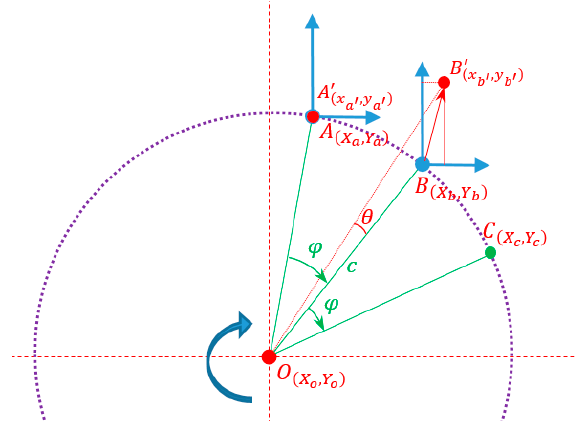
Figure 11. Ball lens coordinate frame BX b Y b .